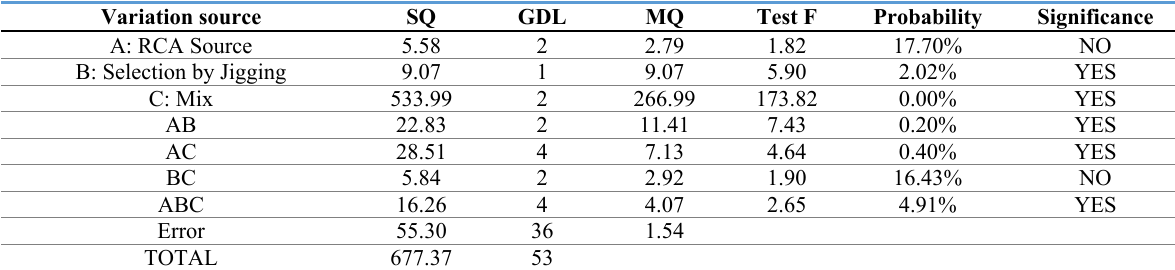
Table 6. Analysis of Variance (ANOVA) for compressive strength.